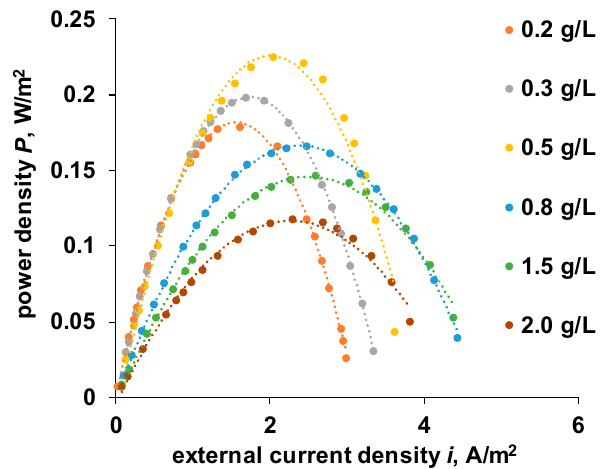
It is known that the maximum power can be obtained when the resistance of the ex-